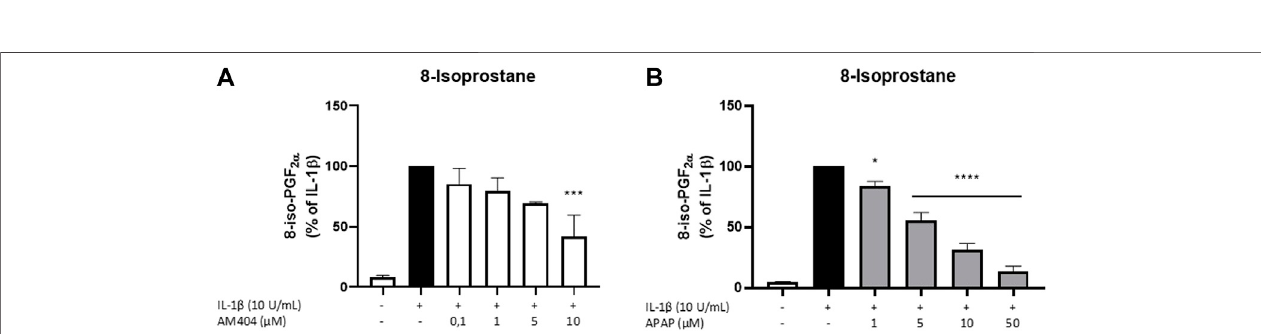
FIGURE 3 | Effects of AM404 on COX-1 enzyme activity (A) and COX-2 enzyme activity (B) in SK-N-SH-cells. (A) COX-1-activity was measured after 15 min of incubationwitharachidonicacid(AA).LevelsofPGE 2 inthesupernatantswerequanti fi edbyEIA. (B) After24 hIL-1 β -pre-stimulation,15 µMofAAwasaddedandPGE 2 - releasewasmeasured byEIA.Values arepresented asthemean ± SEMofatleastthree independent experiments. Statisticalanalysiswascarried outbyusing one-way ANOVA with Dunnett ’ s post hoc tests with ** p < 0.01, **** p < 0.0001 compared to AA (A) or IL-1 β with AA (B) .